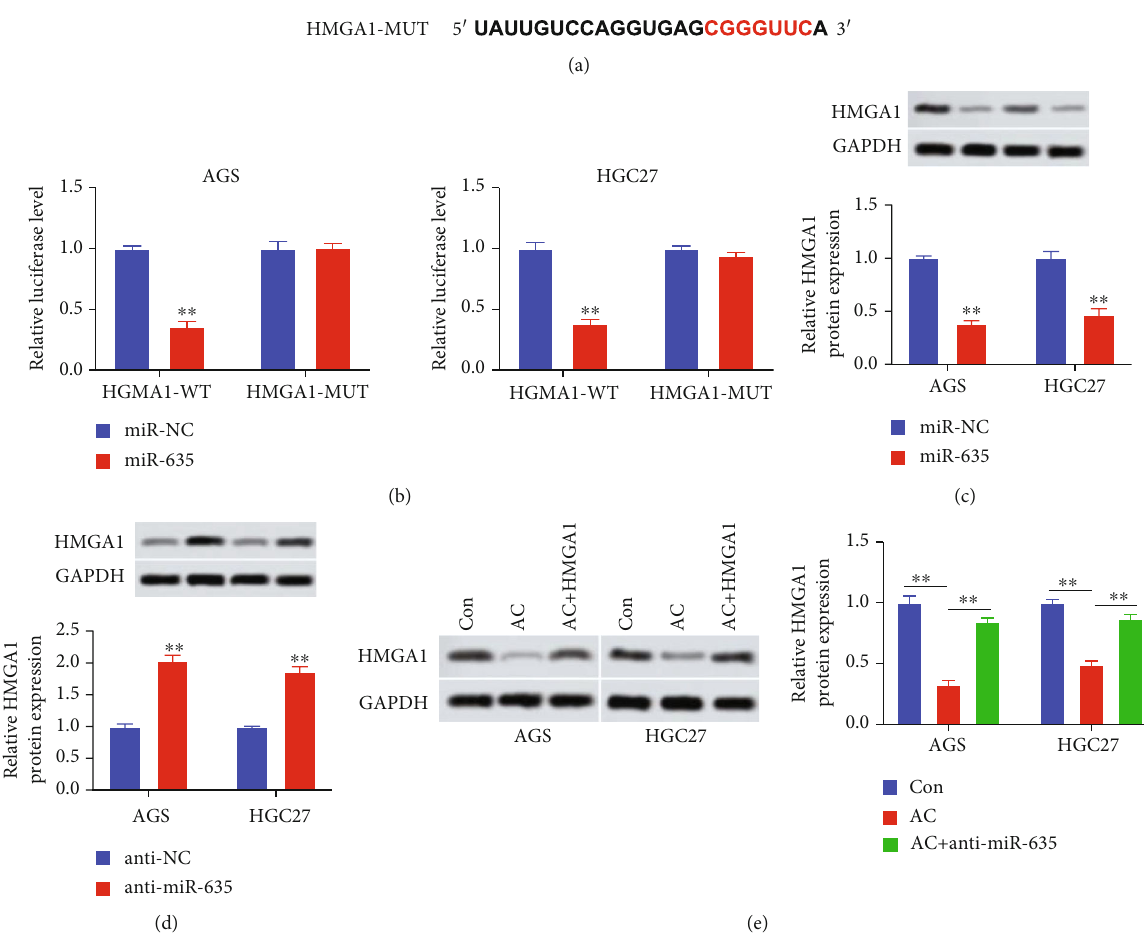
Figure 3: HMGA1 is a target of miR-635. (a) The potential targeting sites of miR-635 and HMGA1 were listed. (b) The target relationship between miR-635 and HMGA1 was testi fi ed using the luciferase assay. (c) The HMGA1 level in AGS and HGC27 cells after miR-635 mimic transfection was determined utilizing Western blot. (d) The HMGA1 level in cells with miR-635 inhibitor transfection was assessed using Western blot. (e) The level of HMGA1 in cells after AC treatment and miR-635 inhibitor transfection was evaluated using Western blot. ∗∗ P < 0 : 01